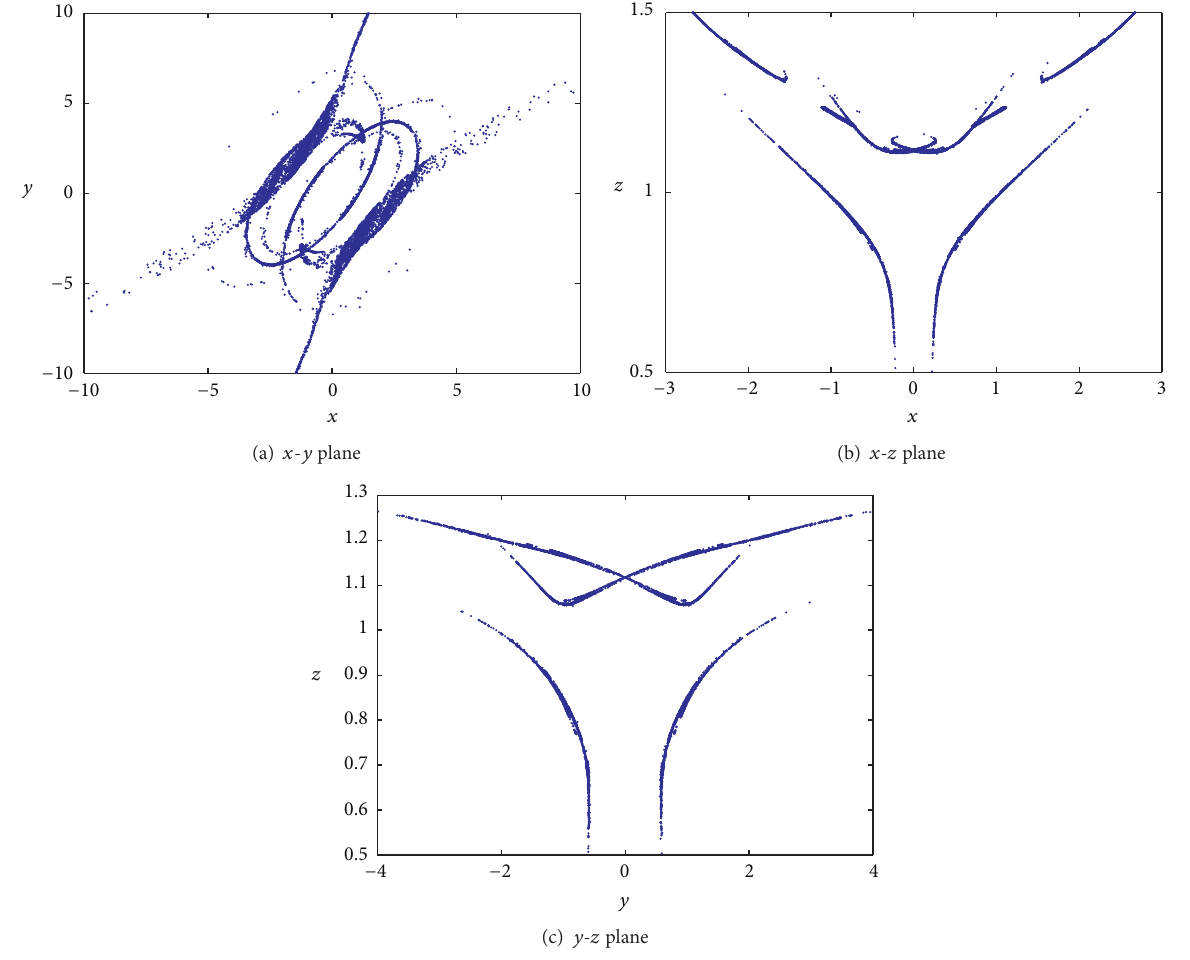
Figure 2: Poincare sections: (a) 𝑧 = 0 ; (b) 𝑦 = 0 ; (c) 𝑥 = 0